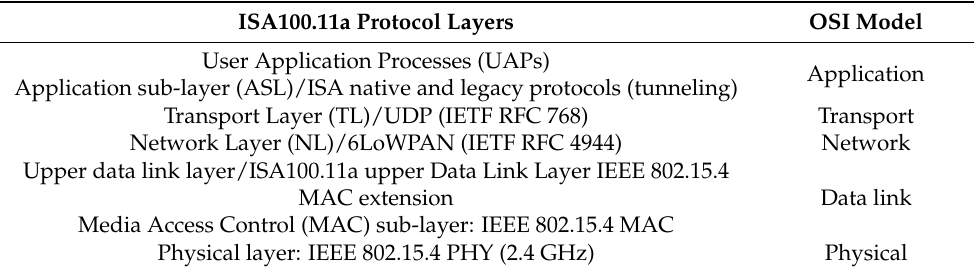
Table 3. Protocol layers of ISA100.11a communications